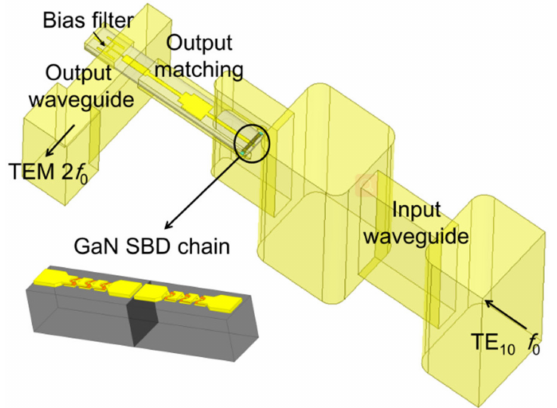
Figure 4. The overall 3D model of 120 GHz frequency doubler in HFSS. The inset shows the GaN SBD chain in the frequency